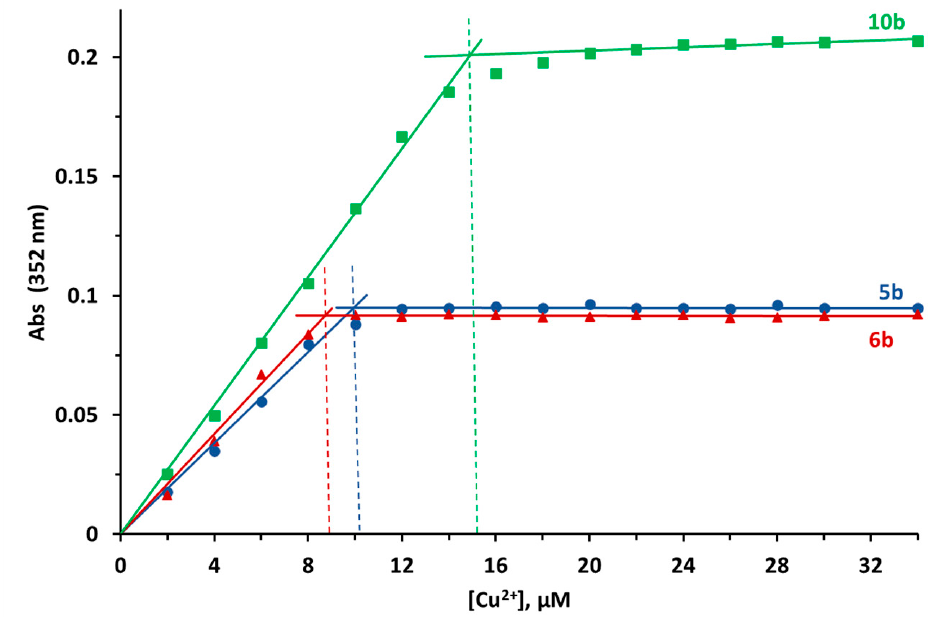
( b ) Figure 8. ( a ) UV absorption spectra of 5b (20 µM) in ethanol after addition of increasing concentra- tions of CuCl 2 (2–34 µM). ( b ) the differential spectra due to the 5b –Cu 2+ complex formation obtained by numerical subtraction from the spectra of the mixture of the spectra of the Cu 2+ alone and 5b alone at the corresponding concentrations. The ratio of ligand/metal ion in the Cu 2+ complexes was investigated for conjugates 5b , 6b and 10b by mixing a fixed concentration of the tested compound (20 µM) with increasing concentrations of metal ion (2–34 µM) [99] (Figures 8a,b, S57 and S58). The ti- tration curves (Figure 9) suggested a 2:1 molar ratio of 5b to Cu 2+ in the complex. The